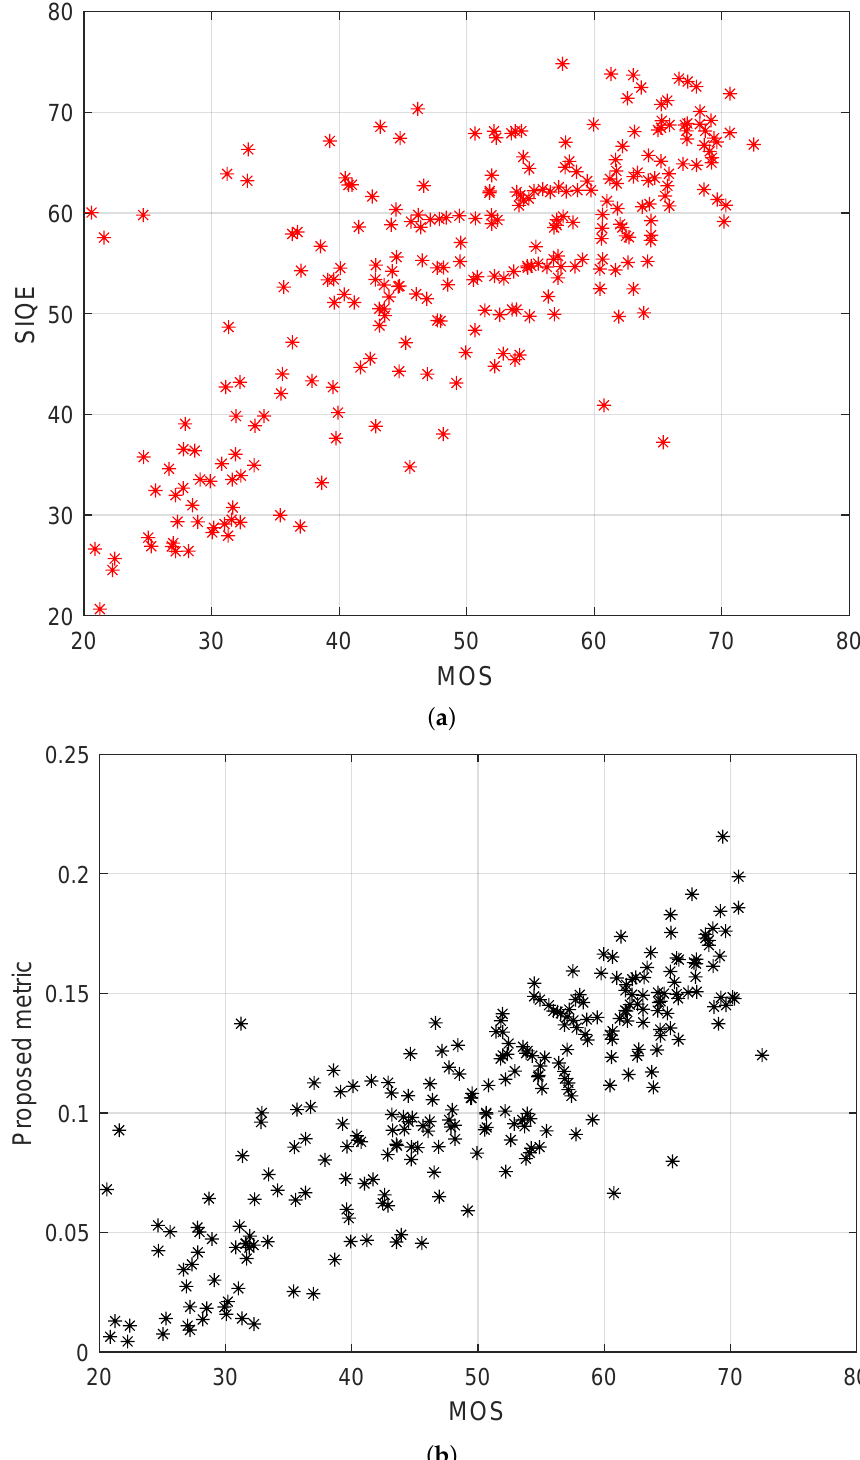
Figure 4. Scatter plots for SIQE ( a ) and the proposed metric ( b ) obtained for the whole ISIQA